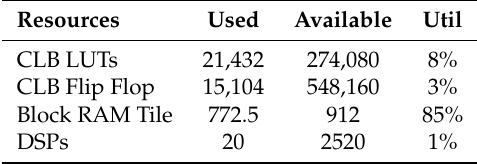
Table 5. Resource utilization summary on XCZU9EG. Resources Used Available